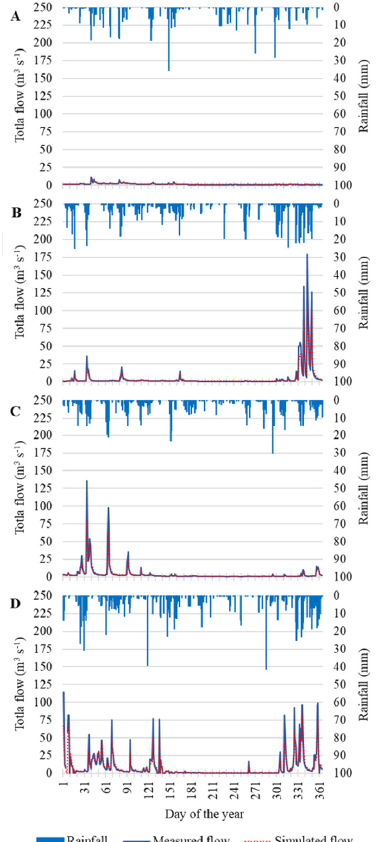
Figure 3. From top to bottom, comparison of daily simulated and measured total flows at the hydrometric station for the year 2007 ( A ), 2008 ( B ), 2009 ( C ), 2010 ( D ). Daily rainfall data are reported. 3.2. Measured Soil Loss Differences between Steepness Classes VINE (20.2 t·ha − 1 ·y − 1 ) scored the highest average soil loss, followed by IRFC (16.92 t·ha − 1 ·y − 1 ), OLIV (8.62 t·ha − 1 ·y − 1 ), and NIFC (8.41 t·ha − 1 ·y − 1 ), while FRSD (0.93 t·ha − 1 ·y − 1 ) scored the lowest one